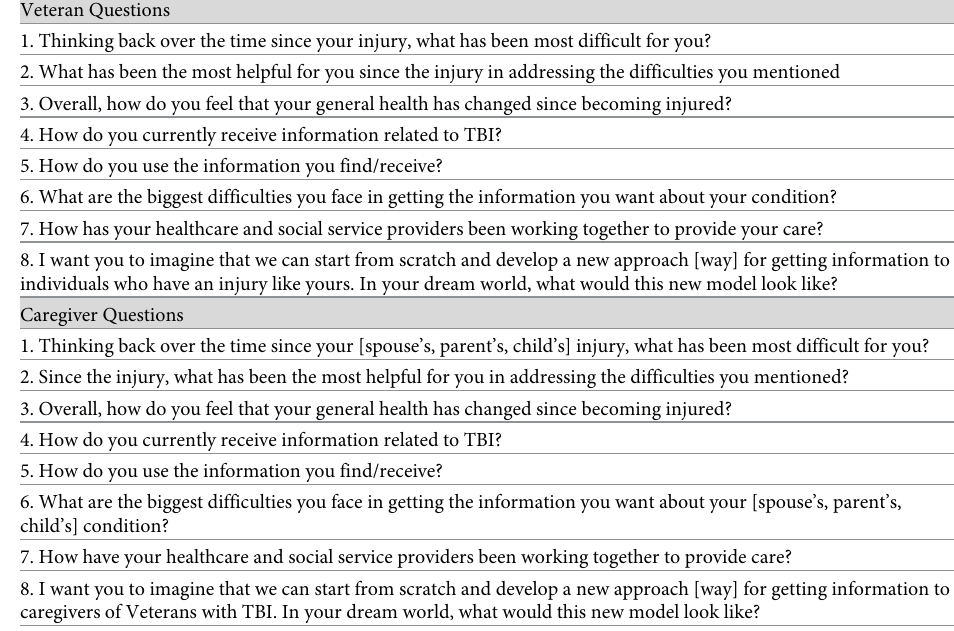
Table 1. Semi-structured interview